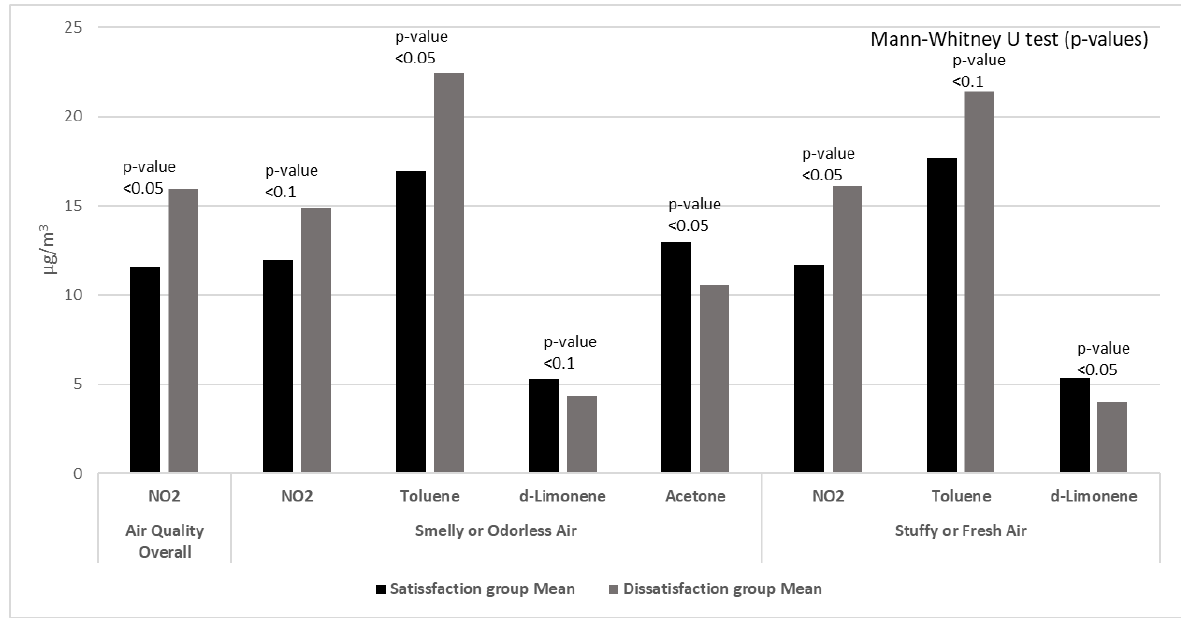
Figure 13. Differences in indoor concentrations (μg/m 3 ) between air quality parameters (satisfaction vs. dissatisfaction group). Table 6. HQ values in all buildings under investigation for formaldehyde and benzene.